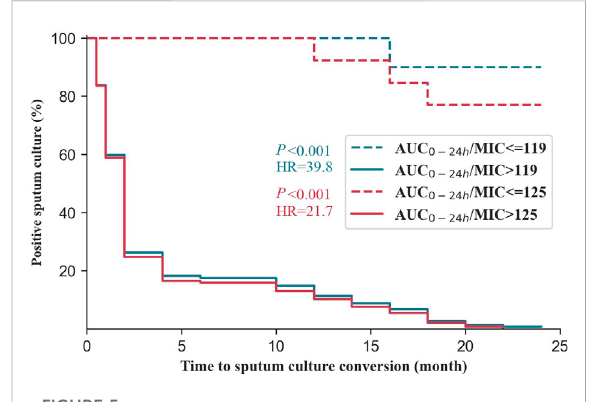
FIGURE 5 Time to culture conversion among the studied participants in validationcohortwithmultidrug-resistanttuberculosisgroupedby the threshold in this study and previously reported target. Note: AUC 0 – 24h /MIC of 125 was derive from boosted classi fi cation and regression tree analyses in the study. The previously reported target of AUC 0 – 24h /MIC 119 (Srivastava et al., 2017)was identi fi ed using the MGIT assay (Becton Dickinson, Franklin Lakes, NJ) to identify MIC in hollow fi ber infection model as the reference for comparison. Abbreviations:AUC0-24 h:0-to24-hareaunderthe concentration-time curve; MIC: minimum inhibitory